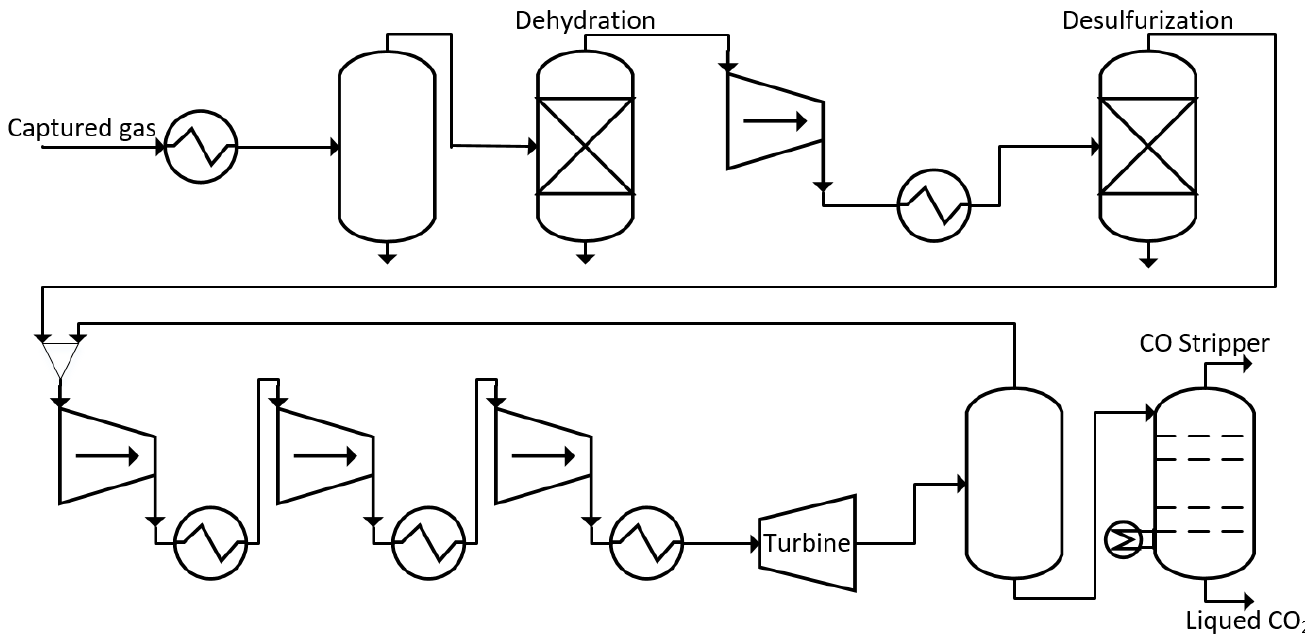
Figure 6. Process flow diagram for the open-cycle liquefaction design with a turbine.